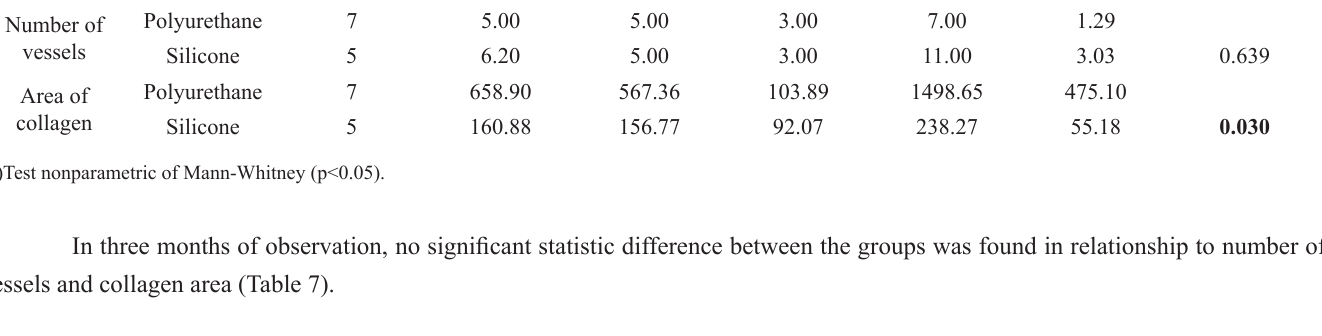
TABLE 7 - Moment of three months comparing number of vessels and collagen